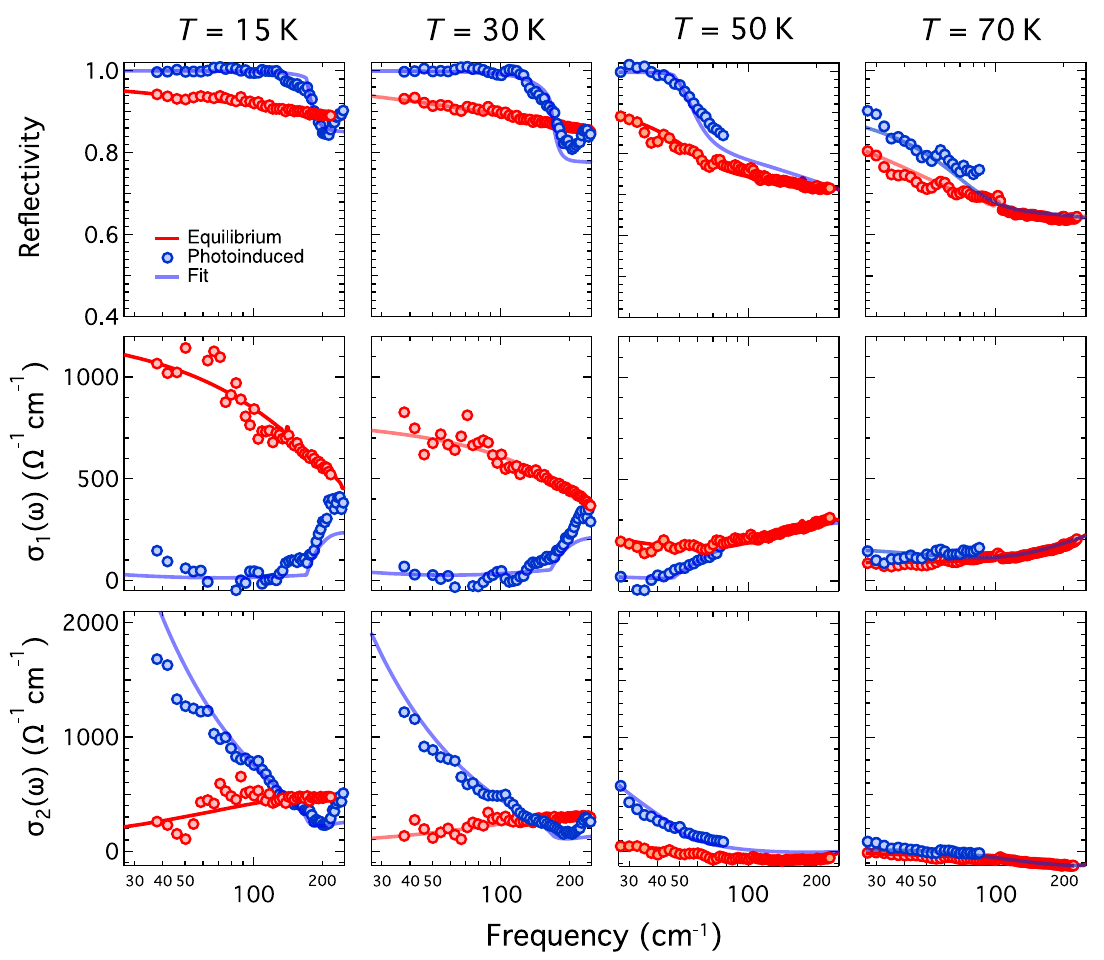
FIG. 3. In-plane reflectivity, real and imaginary parts of the optical conductivity measured in κ - ð ET Þ 2 Cu ½ N ð CN Þ 2 (cid:3) Br at equilibrium (red circles) and at τ ≃ 1 ps time delay after vibrational excitation (blue circles), at four different base temperatures between 15 K and 70 K. Lines are corresponding fits to the spectra. These fits were performed with a Drude-Lorentz model for the equilibrium response at all temperatures and for the transient spectra at T ¼ 70 K. A Mattis-Bardeen model for superconductors was used instead for the out-of- equilibrium response at T ≤ 50 K. All data have been taken upon vibrational excitation close to resonance with the C ═ C stretching ≃ 1250 cm − 1 ), with a pump fluence of 2 mJ = cm 2 . mode ( ν pump